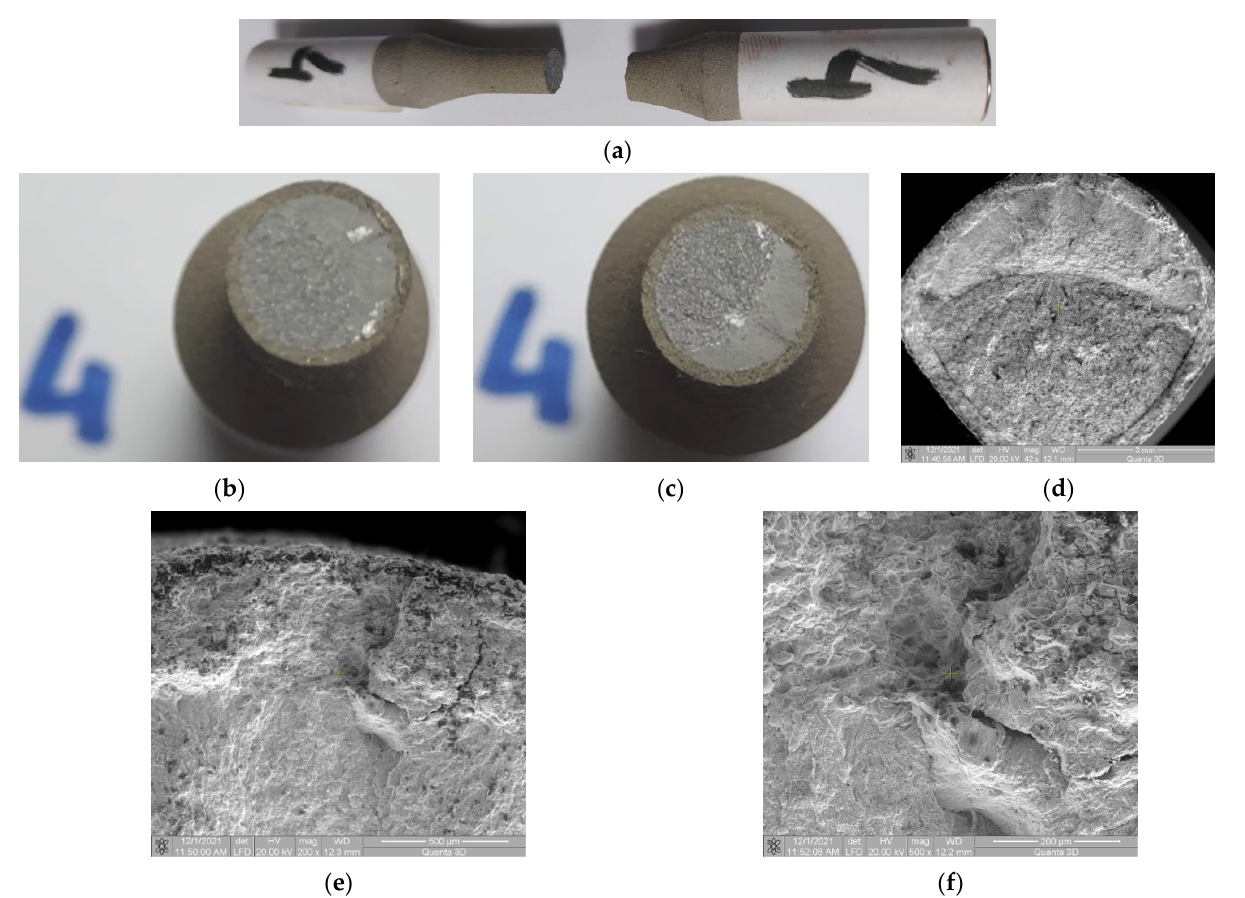
Figure 12. Macroscopic and microscopic appearance of broken surfaces for Sample 4, σ max = 477 MPa, N = 878,965 cycles. ( a ) Sample 4 broken by fatigue. ( b , c ) Fracture surfaces. ( d ) SEM image of the fracture surface at 42× magnification. SEM image of the area where a crack initiated with ( e , f ) 200×, and 500× magnification.